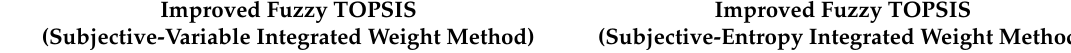
Table 8. Variable weight state vector and subjective-variable integrated weight for 12 failure modes.